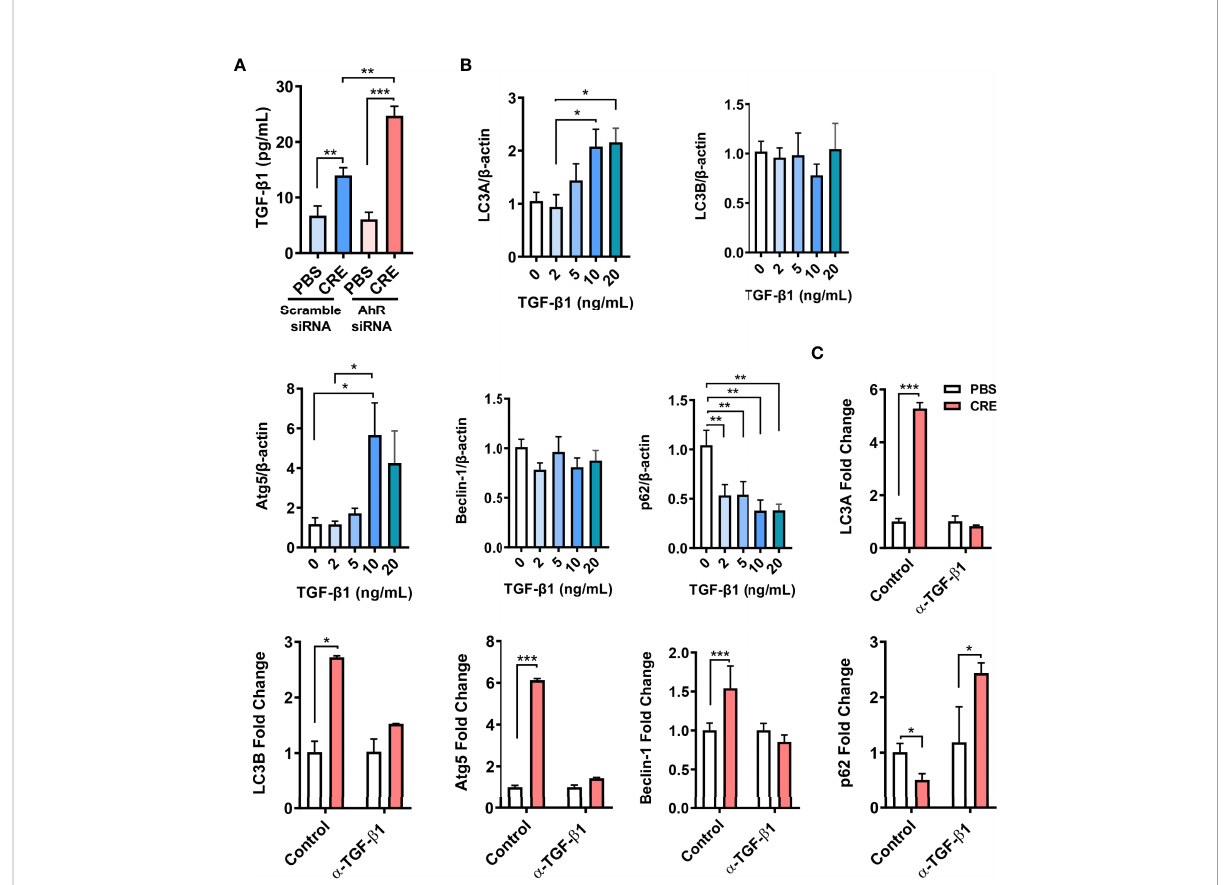
FIGURE 6 TGF- b 1 is required in AhR-mediated cockroach allergen – induced autophagy. (A) ELISA analysis of TGF- b 1 levels in supernatants of cockroach allergen (CRE) – treated HEBCs with or without AhR siRNA knockdown. (B) Expression of LC3A, LC3B, Atg5, Beclin-1, and p62 in the recombinant TGF- b 1 – treated HBECs at different concentrations. (C) Expression of LC3A, LC3B, Atg5, Beclin-1, and p62 in cockroach allergen (CRE-treated) HBECs in the presence or absence of TGF- b 1 neutralizing antibody ( a -TGF- b 1). Data represent means ± SEM of at least two independent experiments. * p < 0.05, ** p < 0.01, and *** p <